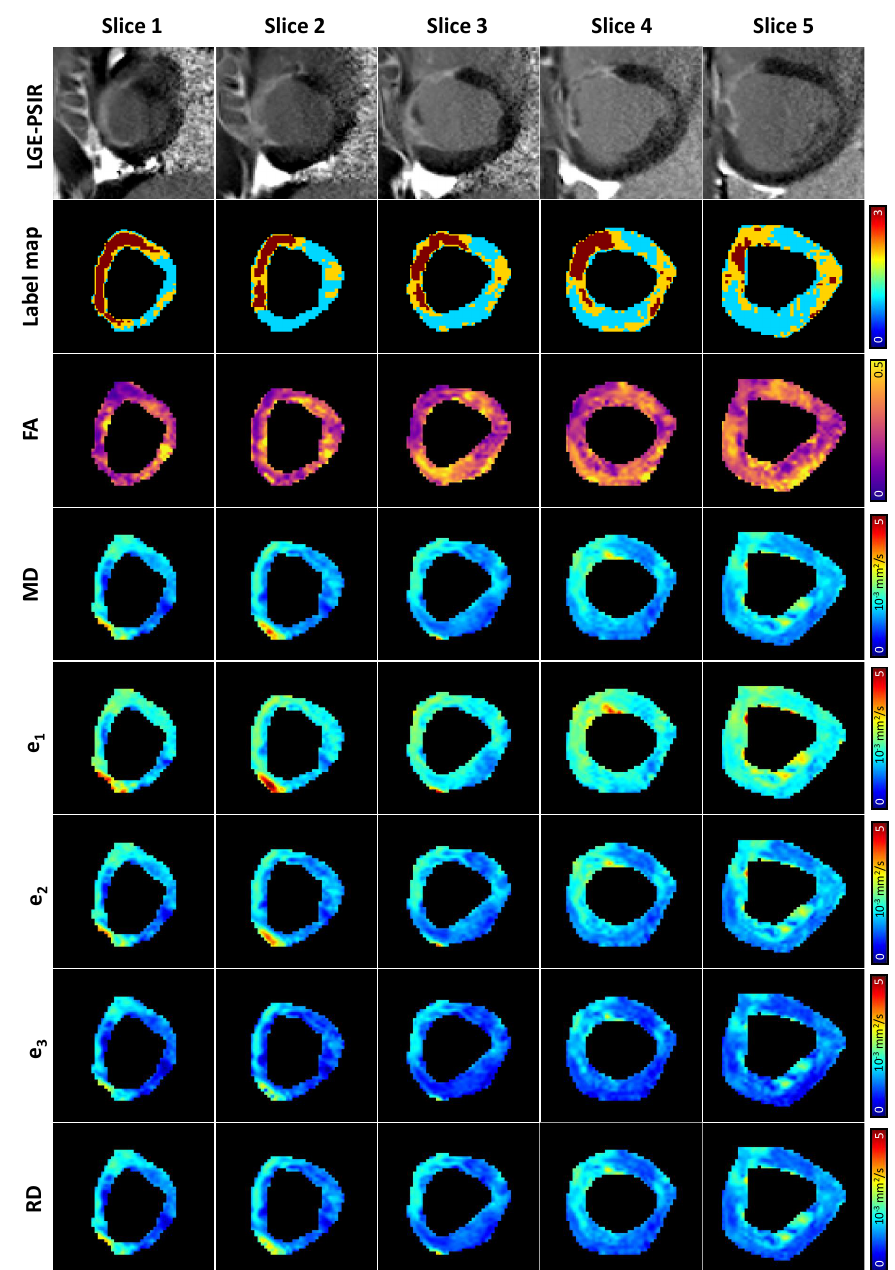
Figure 4. LGE-PSIR and corresponding label maps registered to cDTI along with fractional anisotropy (FA), mean diffusivity (MD), primary eigenvalue (e 1 ), secondary eigenvalue (e 2 ), tertiary eigenvalue (e 3 ), and radial diffusivity (RD) maps for five representative short-axis slices in an infarcted